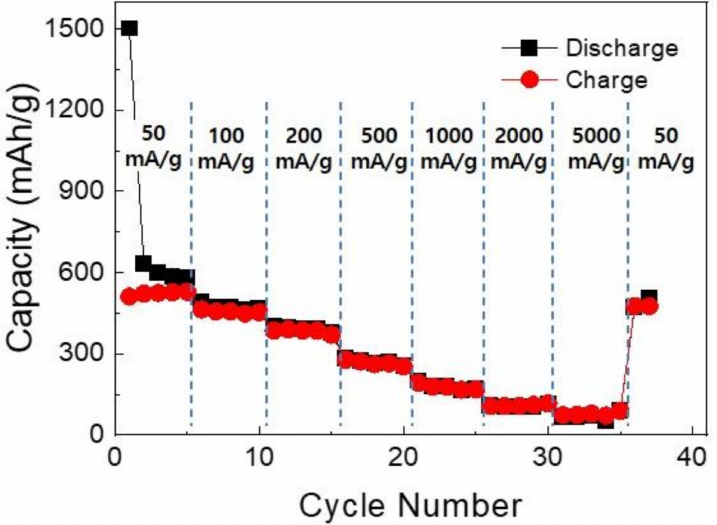
Figure 8. X-ray photoelectron ( a ) Sn 2d and ( b ) C 1s spectra for the RGO/F-SnS NCs.